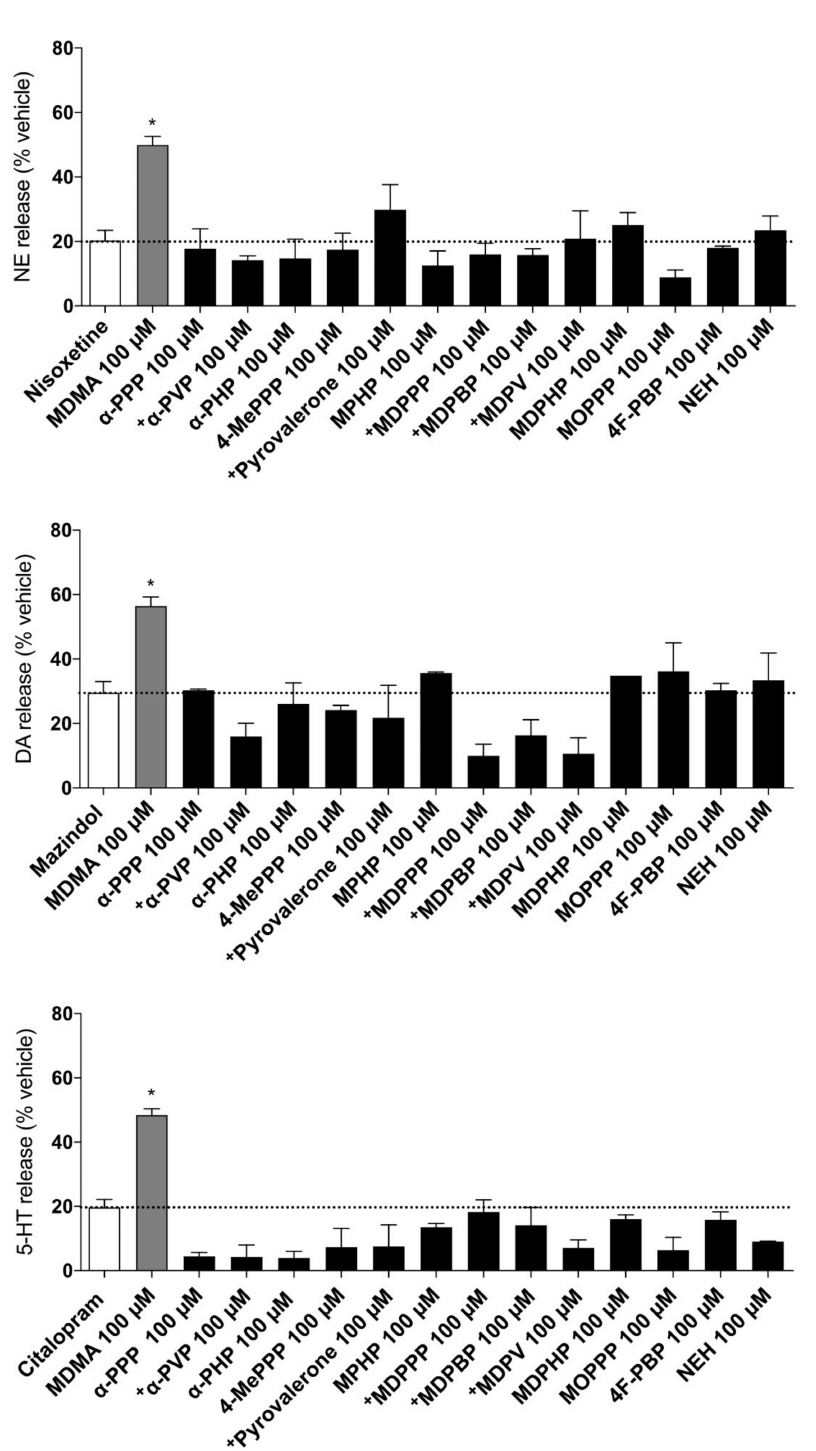
Figure 3. Monoamine efflux induced by 100 µ M of drug in HEK293 cells expressing human NET, DAT, or SERT preloaded with radiolabeled monoamine. Each compound’s induced monoamine efflux was measured as a percentage of a respective radiolabelled neurotransmitter ([ 3 H]-NE/DA/5-HT) decrease in the monoamine preloaded cells compared to the control. Nonspecific “pseudo-efflux” that occurs as a result of monoamines diffusion and subsequent reuptake inhibition has been indicated as a dashed line on the graphs. A substance was a monoamine transporter substrate if it produced significantly (* p < 0.05) more monoamine efflux than each respective pure uptake inhibitor (nisoxetine, mazindol, or citalopram). Data presented is shown as the mean ± SEM. Monoamine efflux data for some pyrovalerone cathinones (indicated as + ) was adapted from a previous publication